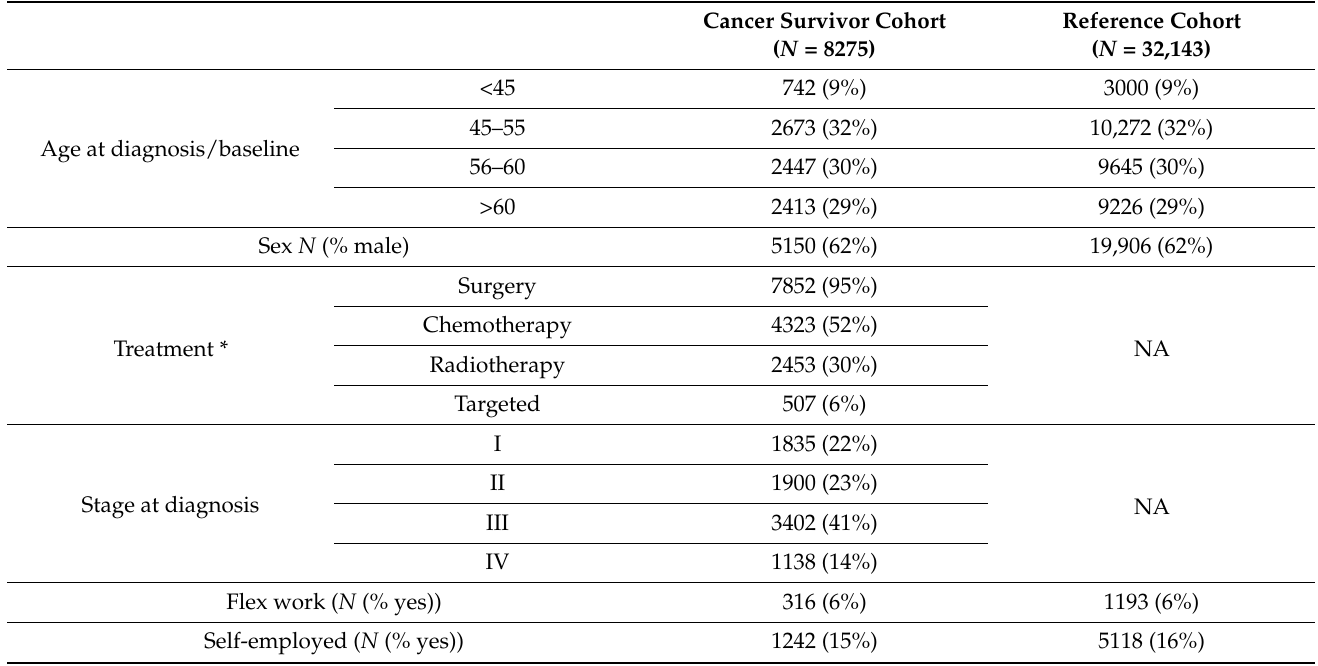
Table 2. Characteristics of the cancer survivor cohort and the reference cohort having paid